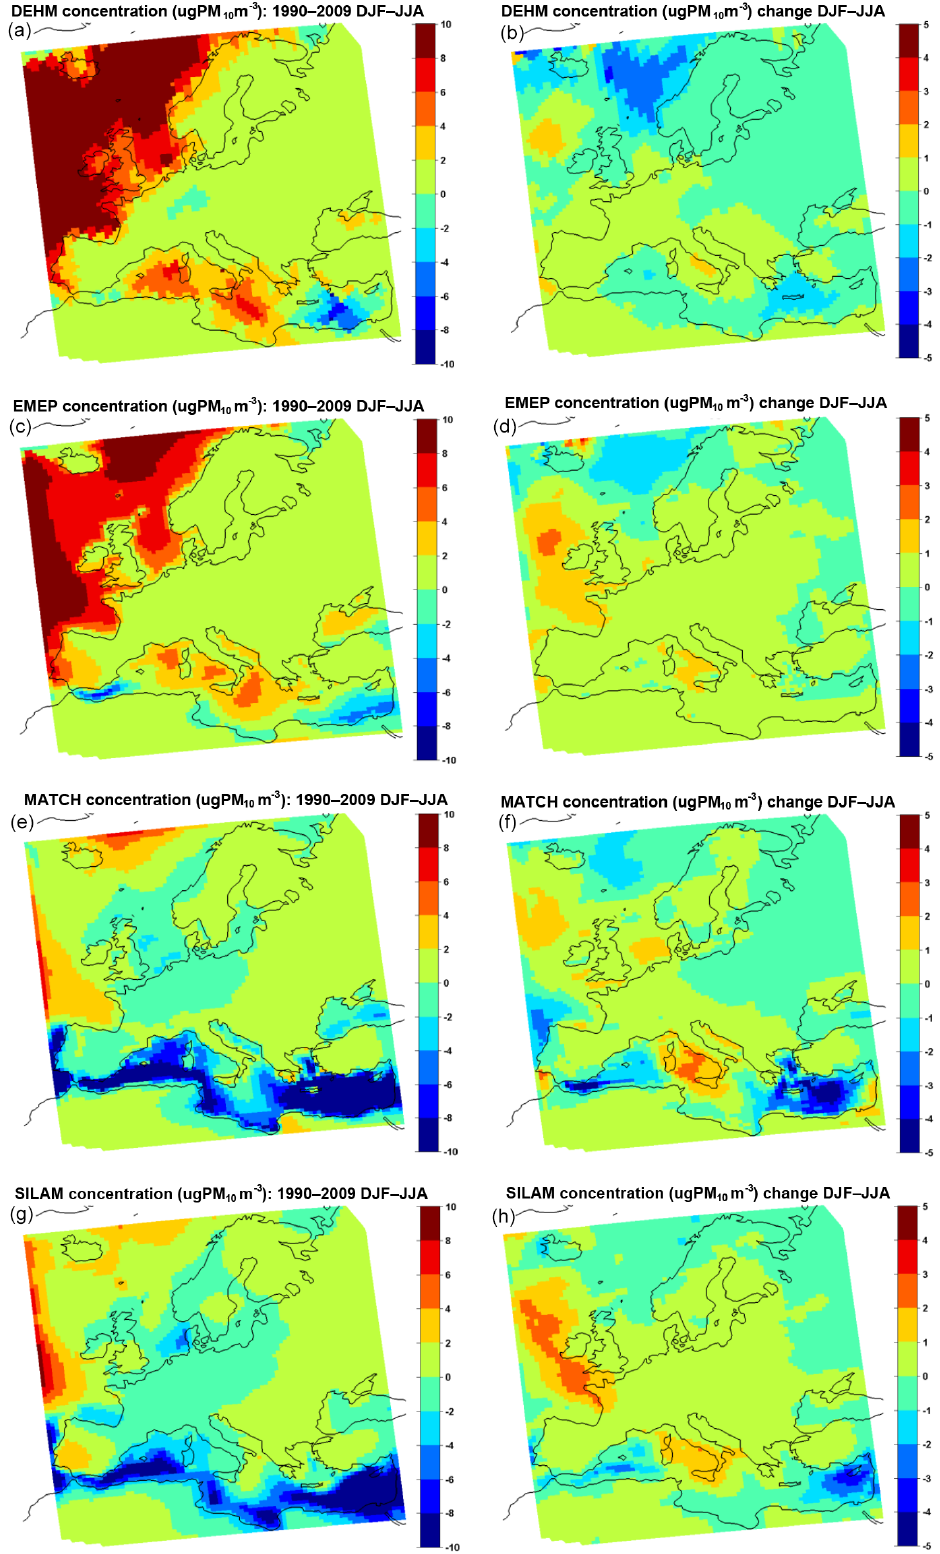
Figure 6. Sea salt concentration (µgPM 10 m − 3 ) difference between winter (December, January, and February: DJF) and summer (June, July, and August: JJA) for DEHM, MATCH, and SILAM models. Left panels: past period (1990–2009); right panels: absolute difference between the future (2040–2059) and past